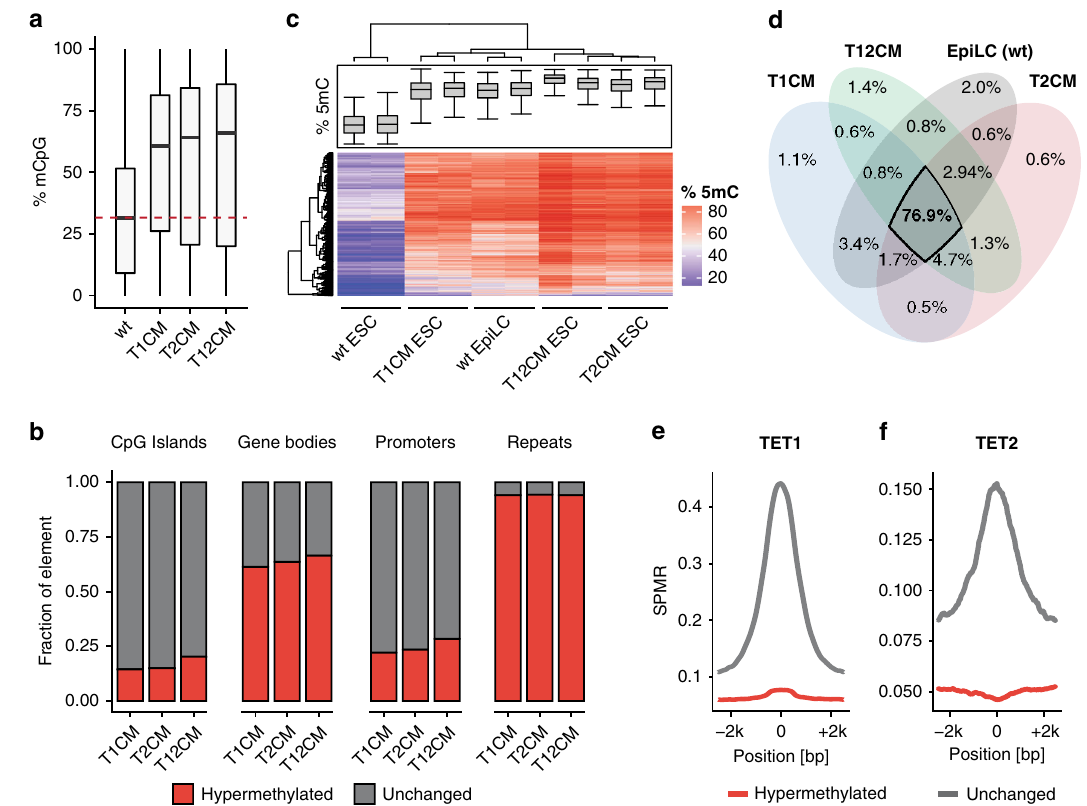
Fig. 1 TET1 and TET2 prevent hypermethylation of the naïve genome. a Loss of TET catalytic activity leads to global DNA hypermethylation. Percentage of total 5mC as measured by RRBS. For each genotype, n = 2 biologically independent samples per condition. b Loss of TET catalytic activity leads to widespread DNA hypermethylation especially at repetitive elements. Relative proportion of DNA hypermethylation ( q value < 0.05; absolute methylation difference >20%) at each genomic element in T1CM, T2CM, and T12CM ESCs compared to wt ESCs. c Heat map of the hierarchical clustering of the RRBS data depicting the top 2000 most variable 1 kb tiles during differentiation of wt ESCs to EpiLCs with n = 2 biologically independent samples per genotype and condition. d Venn diagram depicting the overlap of hypermethylated (compared to wt ESCs; q value < 0.05; absolute methylation difference >20%) sites among T1CM, T2CM, and T12CM ESCs and wt EpiLCs. e , f TET binding is not associated with DNA hypermethylation in TET mutant ESCs. Occupancy of ( e ) TET1 66 and ( f ) TET2 67 over 1 kb tiles hypermethylated (dark red) or unchanged (dark gray) in T1CM and T2CM ESCs, respectively (SPMR: Signal per million reads). In the boxplots in ( a ) and ( c ), horizontal black lines within boxes represent median values, boxes indicate the upper and lower quartiles, and whiskers extend to the most extreme value within 1.5 x the interquartile range from each hinge. In ( b ) and ( d ), the q -values were calculated with a two- sided Wald test followed by p -value adjustment using SLIM 209